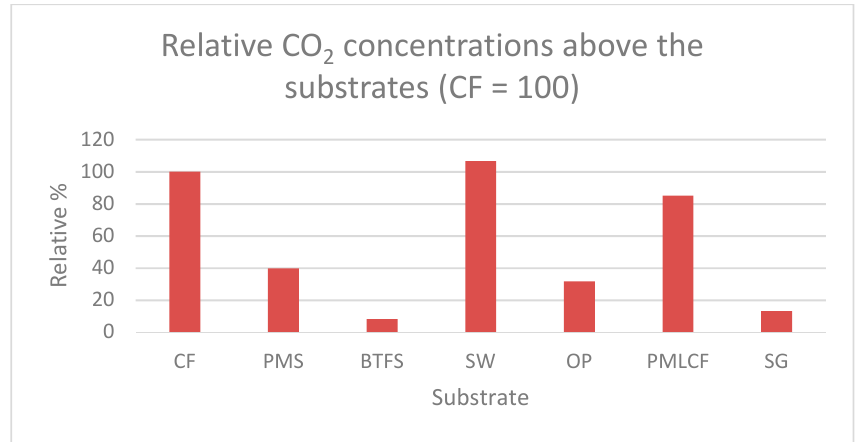
Figure 2. NH 3 concentrations measured in the climate chamber. CO 2 and NH 3 concentrations measured above the different substrates at day 8 are presented in Figures 3 and 4, respectively, and are presented relative to the concentrations measured at CF.